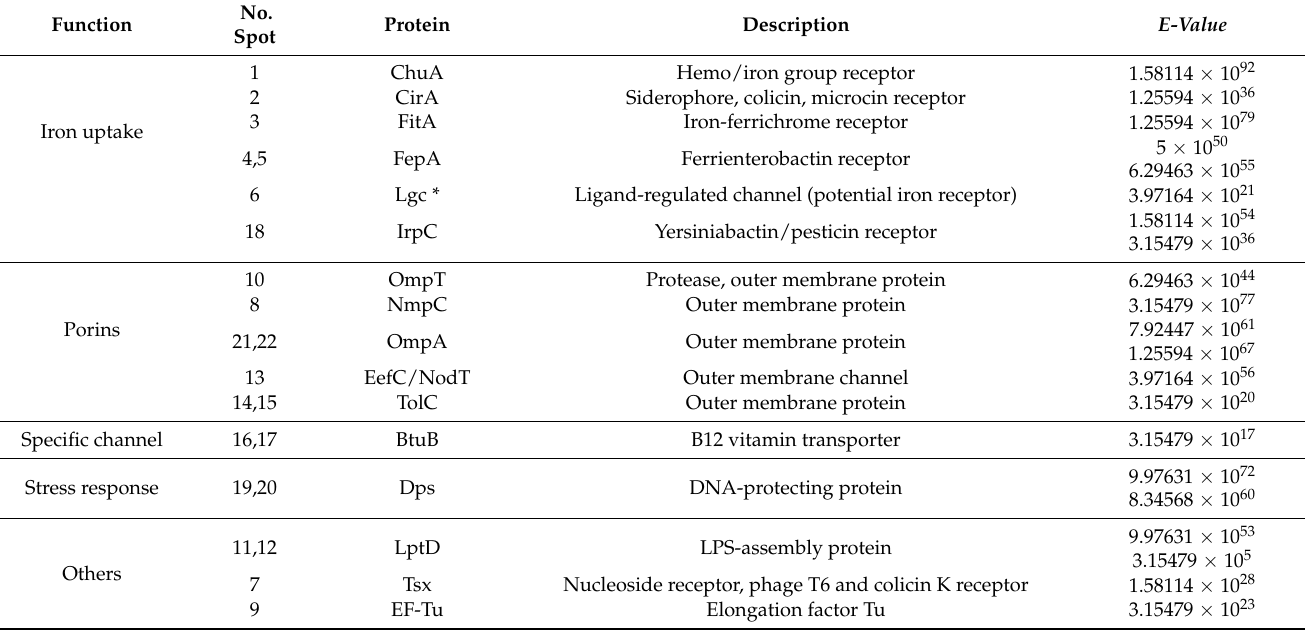
Table 3. Proteins identified by MALDI-TOF/TOF corresponding to those spots present in >70% of the AIEC strains and absent in the commensal E. coli HS